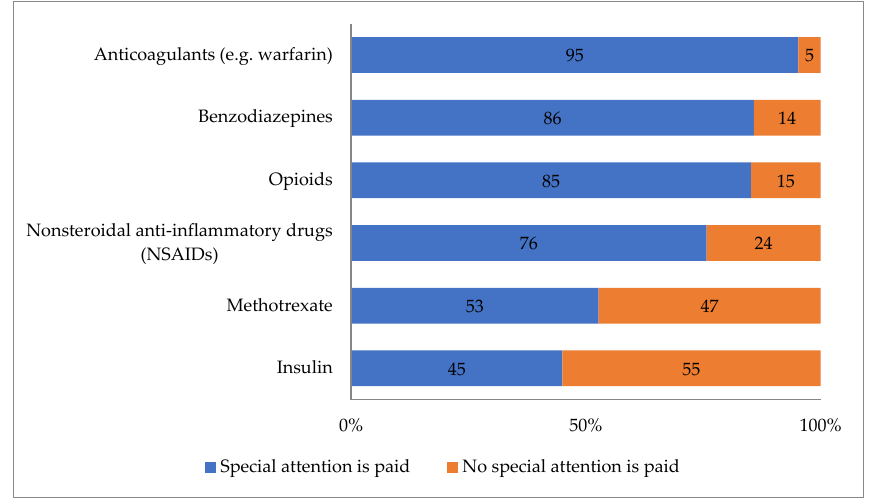
Figure 3. Management of high-risk medications in routine dispensing (% of the responding pharmacies, n = 169).